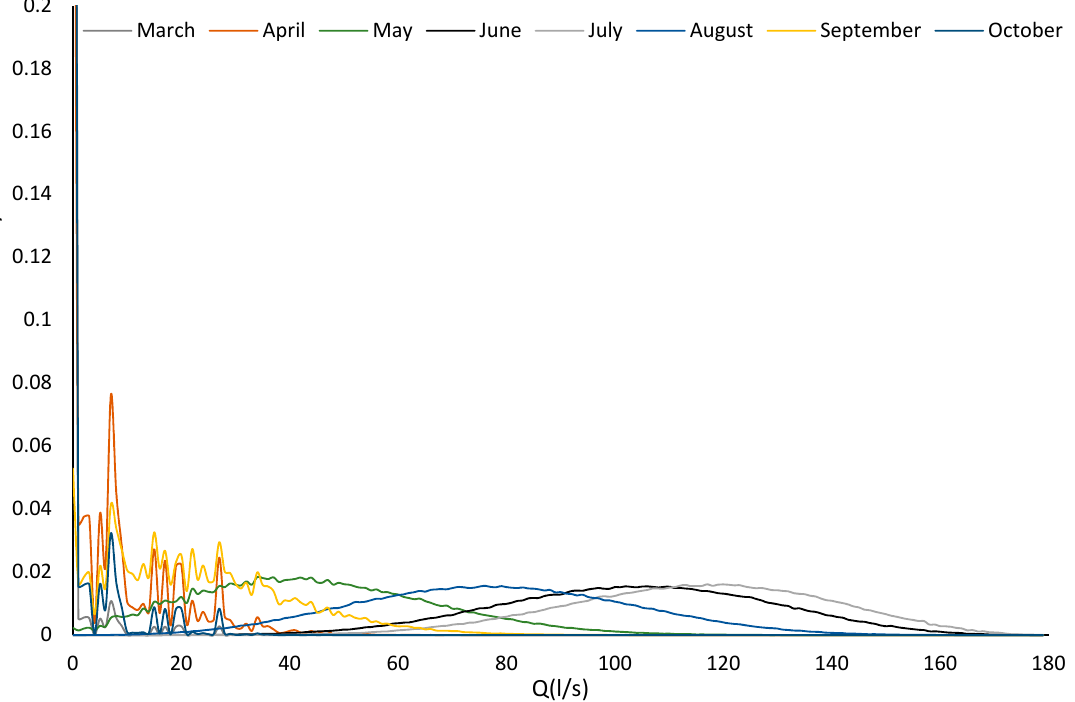
Figure 8. Theoretical irrigation volume requirements and experimental irrigation volume requirements for EPP 3.